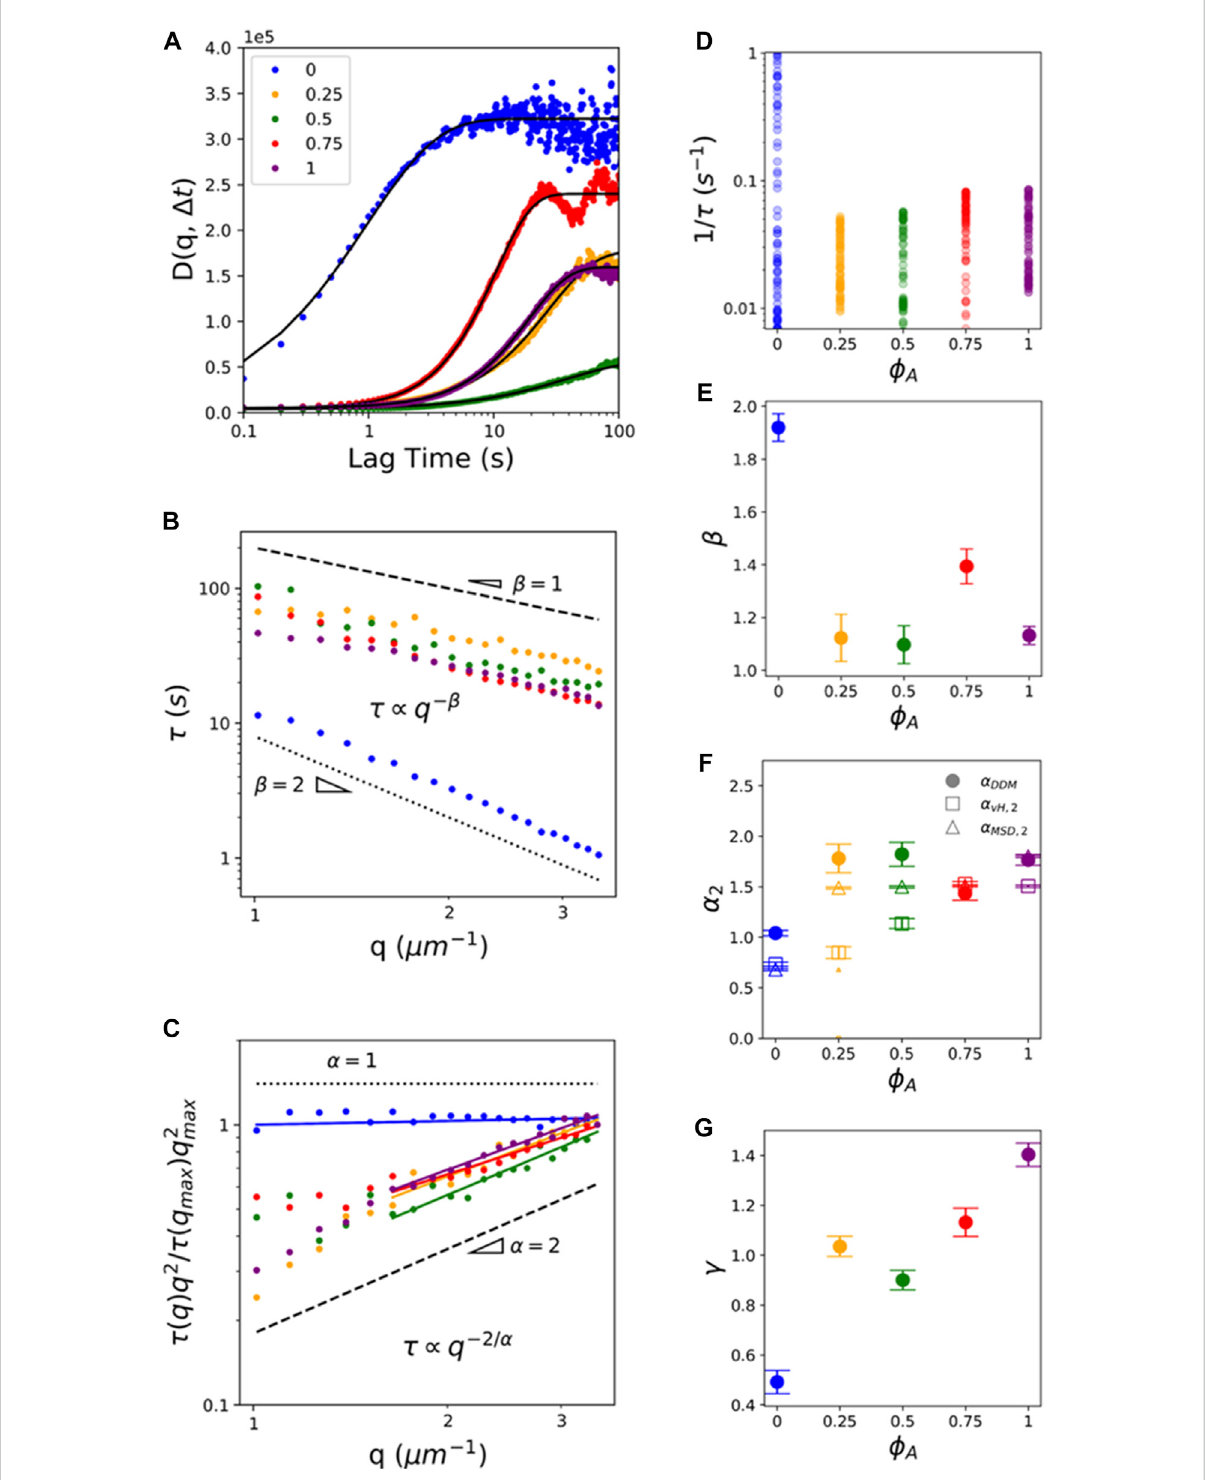
FIGURE 5 DDM analysis reveals ballistic-like transport of particles entrained in active composites at mesoscopic spatiotemporal scales. (A) Sample image structurefunctions D ( q , Δ t ) forcompositeswith actinfractions ϕ A indicated inthelegend. Allcurvesshown areevaluatedat q (cid:2) 3 . 92 μ m − 1 , andsolid black lines are fi ts to the data to determine corresponding q -dependent decay times τ ( q ) and stretching exponents γ , as described in Methods. (B) Decaytimes τ ( q ) foreachcompositeshownin (A) .Dashedanddottedblacklinesshowscaling τ ( q ) ~ q − β forballistic( β (cid:2) 1 ) anddiffusive( β (cid:2) 2